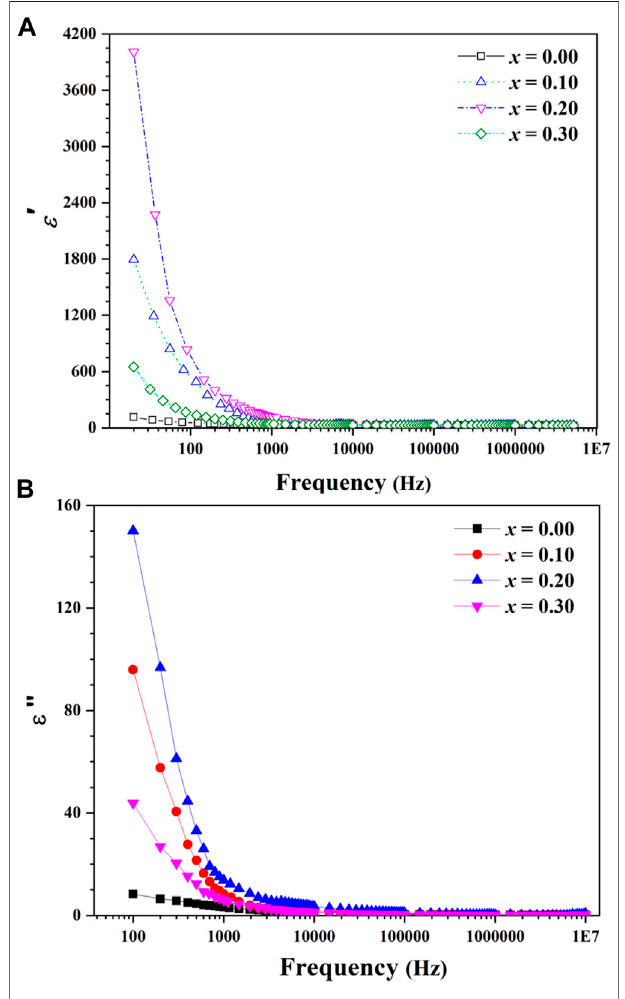
FIGURE 10 | Frequency dependency of (A) real part of dielectric constant and (B) imaginary part of dielectric constant for Mg 0.30- x Cd x Cu 0.2 Zn 0.5 Fe 2 O 4